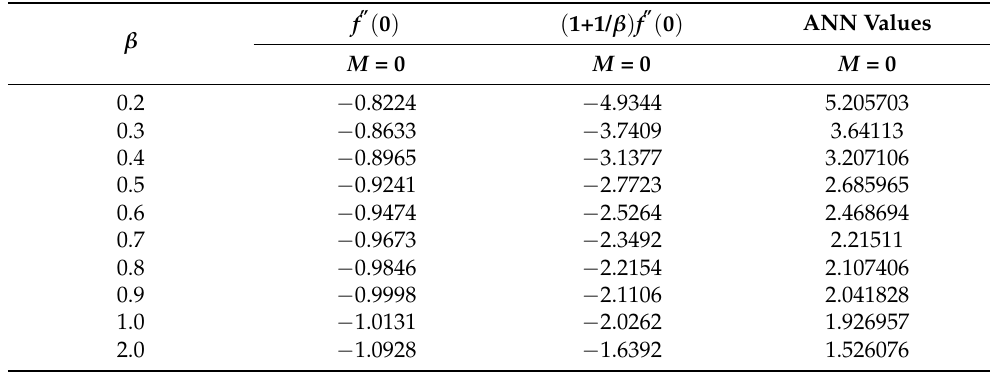
Table 1. Impact of the Casson fluid parameter on the SFC for the nonmagnetic flow field.